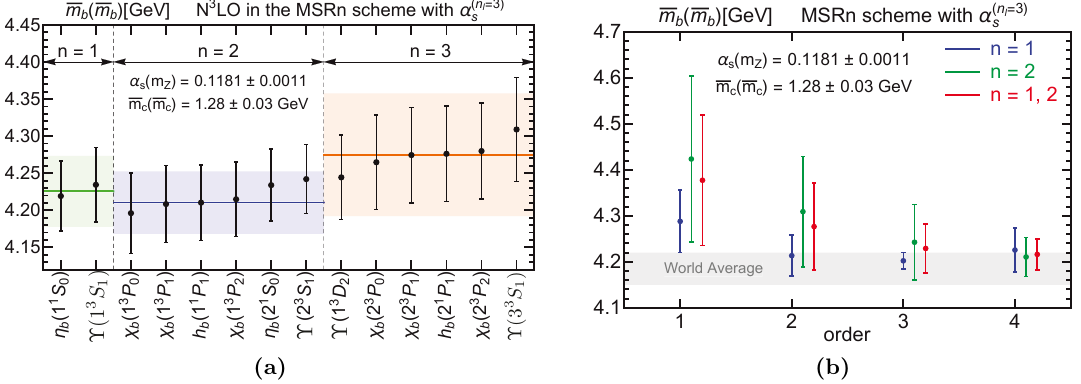
Figure 8. Left panel: bottom quark mass determinations from individual (cid:12)ts to bottomonium states with principal quantum number n (cid:20) 3 (black dots with error bars) and global (cid:12)ts to n = 1 (green band), n = 2 (blue band), and n = 3 states (orange band). All computations at N 3 LO in the MSRn scheme with n ‘ = 3 active (cid:13)avors. Right panel: global (cid:12)ts to n = 1 (blue), n = 2 (green) and n = 1 ; 2 (red) as a function of the perturbative order N n LO. The PDG world average value is shown with a gray band. Both panels: only perturbative uncertainties shown.